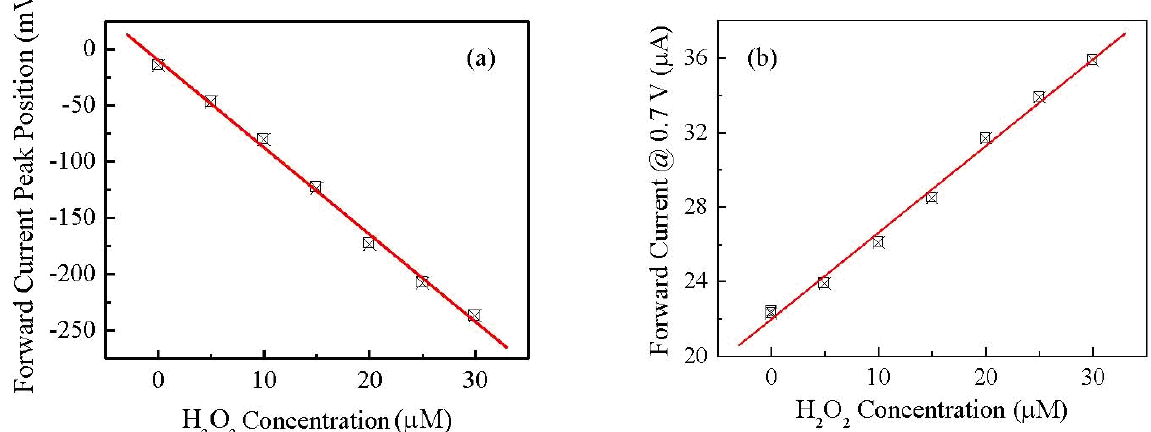
Figure 7. ( a ) Forward current peak position of a gold/Nafion:polypyrrole/MWCNTs device and ( b ) its forward current intensity measured at 0.7 V as a function of H concentration. Data are extracted from the results of the measurements shown in Figure